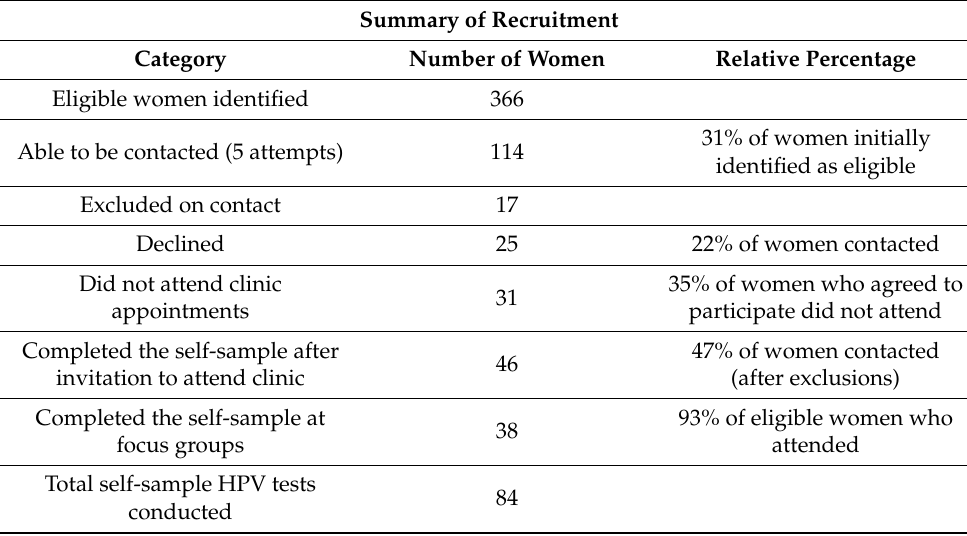
Table 1. Summary of eligibility, contactability and uptake of study offer amongst M¯aori, Pacific and Asian women in West Auckland, New